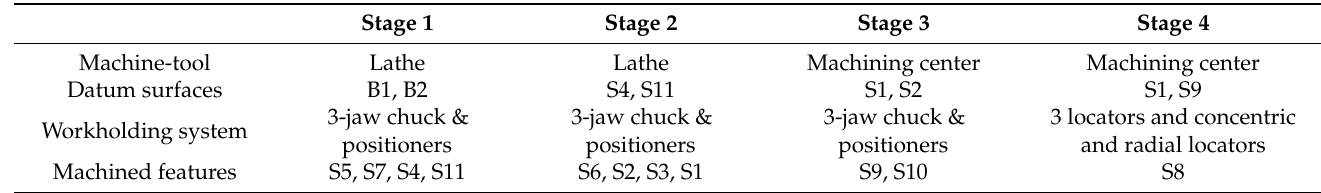
Figure 8. Part to be machined with numbered surfaces. B1, …, means raw surfaces. 1, 2, …, means machined surfaces and are referred in the text as S1, S2, etc. Table 1. Manufacturing process plan for the case study.